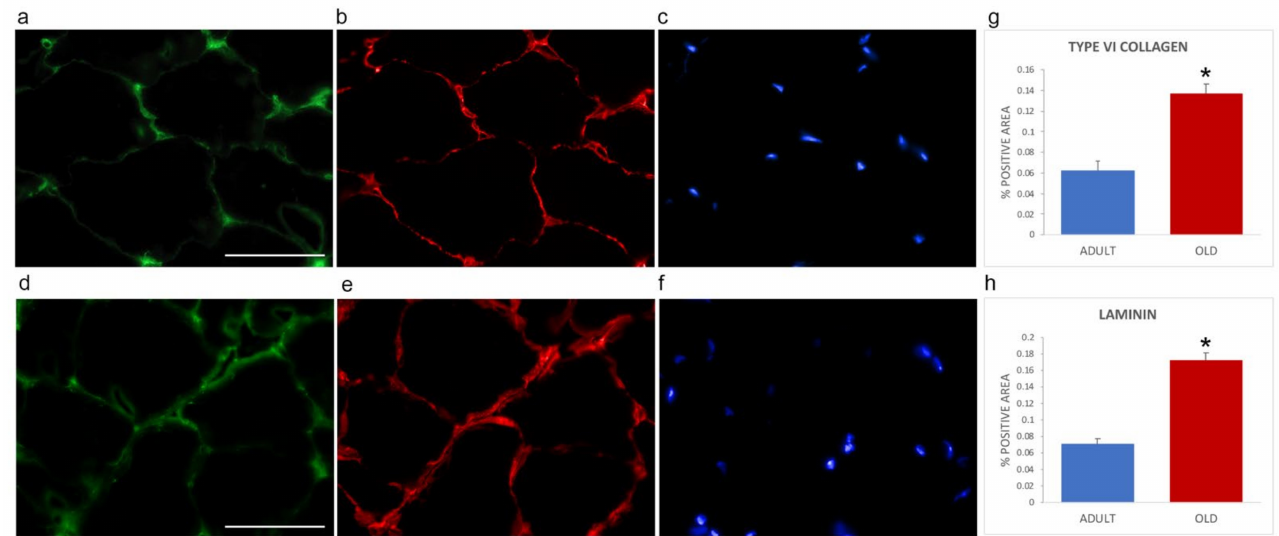
Figure 4. Type VI collagen ( a , d ) and laminin ( b , e ) immunolabelling of gastrocnemius cryosections in adult ( a – c ) and old ( d – f ) mice. DNA was counterstained with Hoechst ( c , f ). Bar: 50 µ m. Panels ( g ) and ( h ), respectively, show quantification of the immunolabelling for type VI collagen and laminin expressed as % of total area). * p <